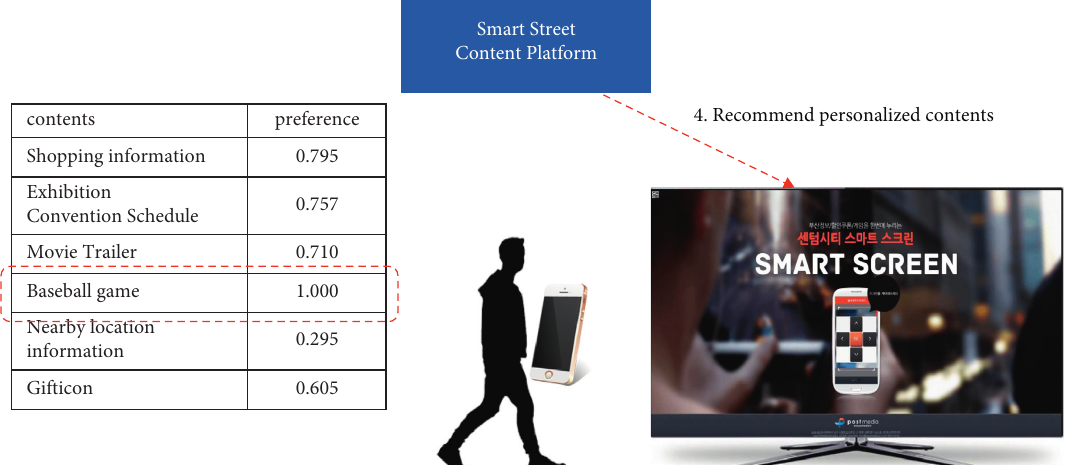
Figure 10: Recommendation